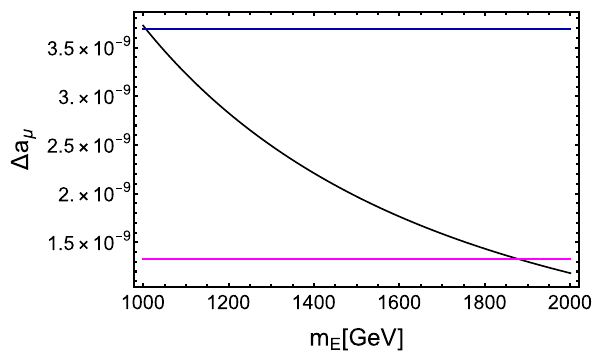
Fig. 7 Muonanomalousmagneticmomentasafunctionofthecharged exotic lepton mass m